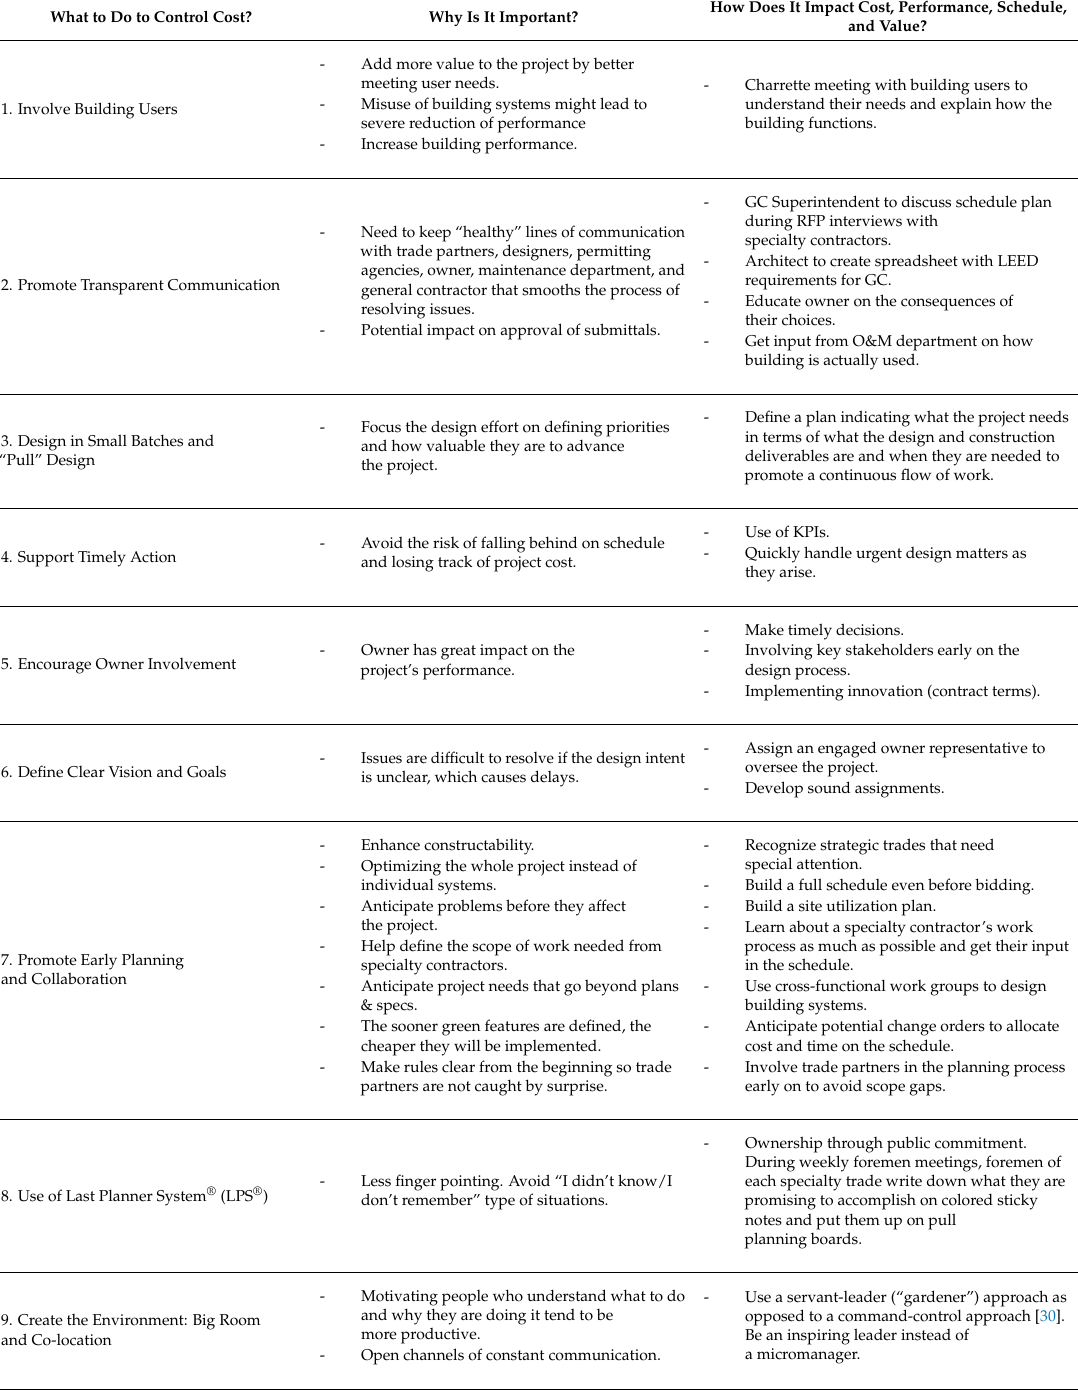
Table 3. TVD-inspired practices to deliver environmentally-conscious